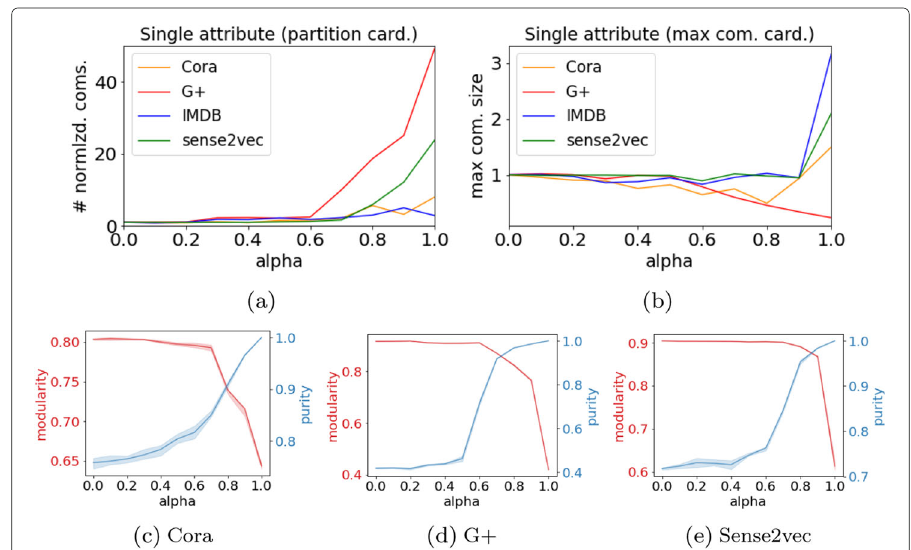
Fig. 1 a Number of communities and b size of the largest community as functions of α . c - e Modularity-Purity as a function of α , where the lines represent the average values over ten executions, and the surrounding areas are the interquartile ranges. E VA works well until the decrease of modularity values (i.e., the red trends): for instance, in G+, it starts from α = 0.6, coherent with a relevant increase of partition